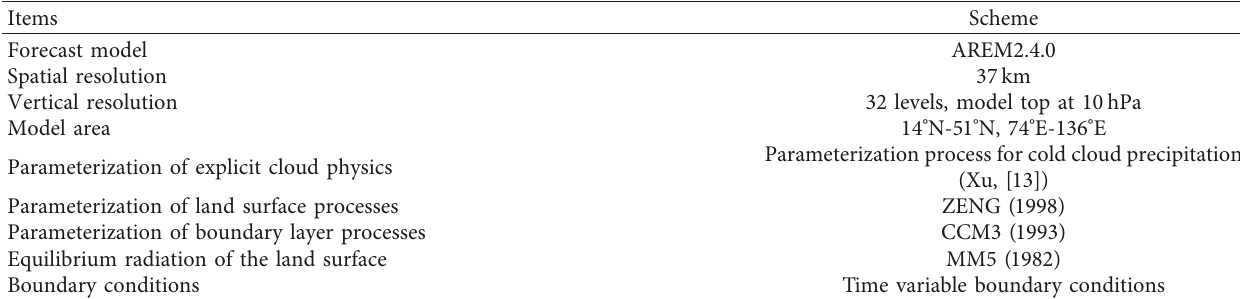
Figure 1: The distribution of GPS RO data in the case study (assimilation time window from 18 UTC on July 3, 2007, to 00 UTC on July 4, 2007) [12]. Table 1: Specific description of the experiment.